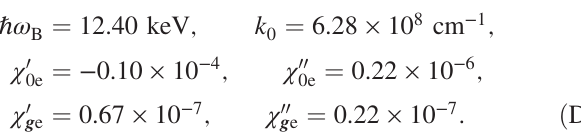
interplanar distance d ¼ 9 . 21 × 10 − 8 cm. The isotope 45 21 Sc has a natural decay width Γ ¼ 1 . 4 × 10 − 15 eV, the internal conversion coefficient α ¼ 400 . The structure factors are C S ð g Þ ¼ 3 . 415 for 45 21 Sc and S ð g Þ ¼ − 10 . 566 for 8 O. The isotopic abundance η ¼ 1